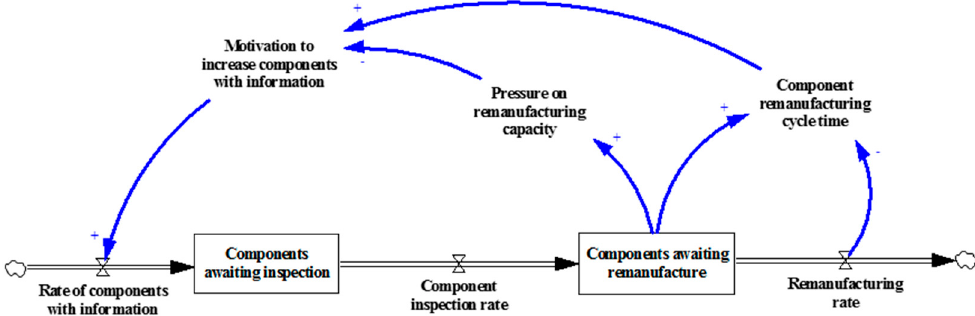
Figure 5. SFD indicating the dynamic implications of component data on the remanufacturing system for the component.